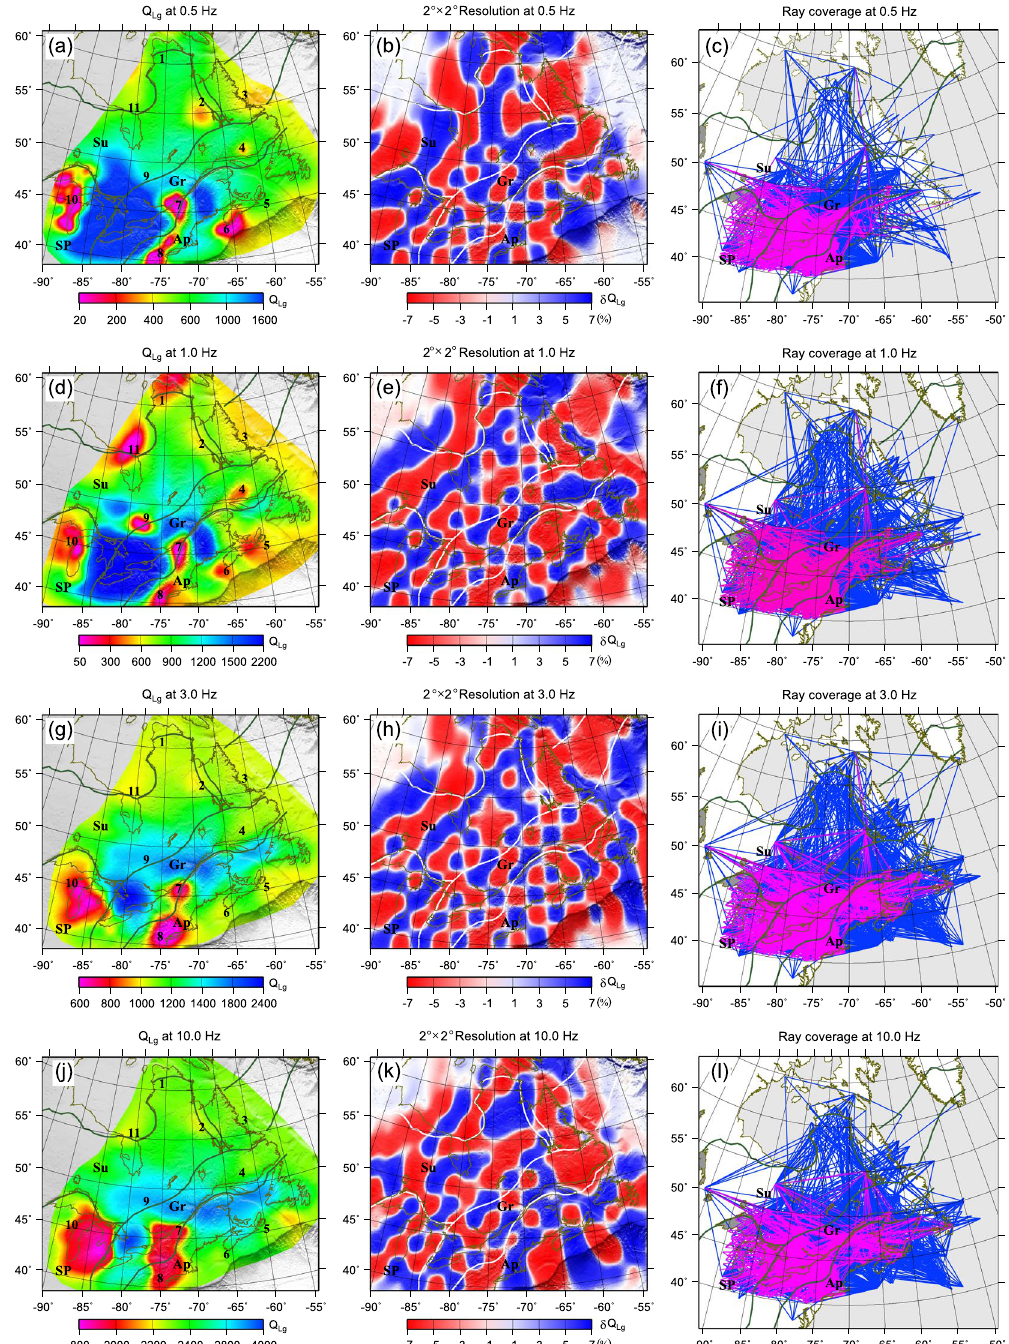
Figure 4. Lateral variation of Q Lg (left), resolution analysis at 2° × 2°(center), and associated ray-path coverage (right) at 0.5 Hz ( a – c ), 1.0 Hz ( d – f ), 3.0 Hz ( g – i ), and 10.0 Hz ( j – l ). Note that different color scales are used for the maps. Numbers are associated to the locations of Q anomalies in the tomography results. Major geological provinces are indicated as; Superior (Su), Grenville (Gr), Appalachian (Ap), and Southern (SP). In c, f, and i, the blue lines are single-station paths, whereas the pink lines are two-station paths. The figure is generated from GMT, which is an open source software available at: